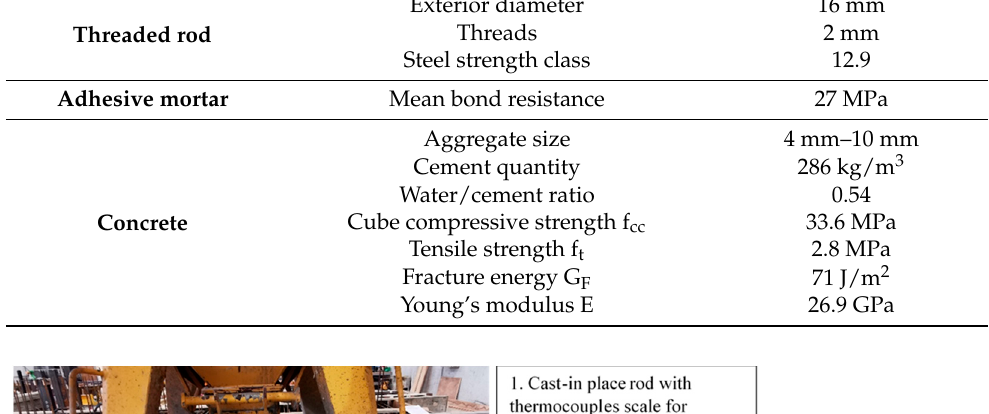
Table 2. Characteristics of the materials.